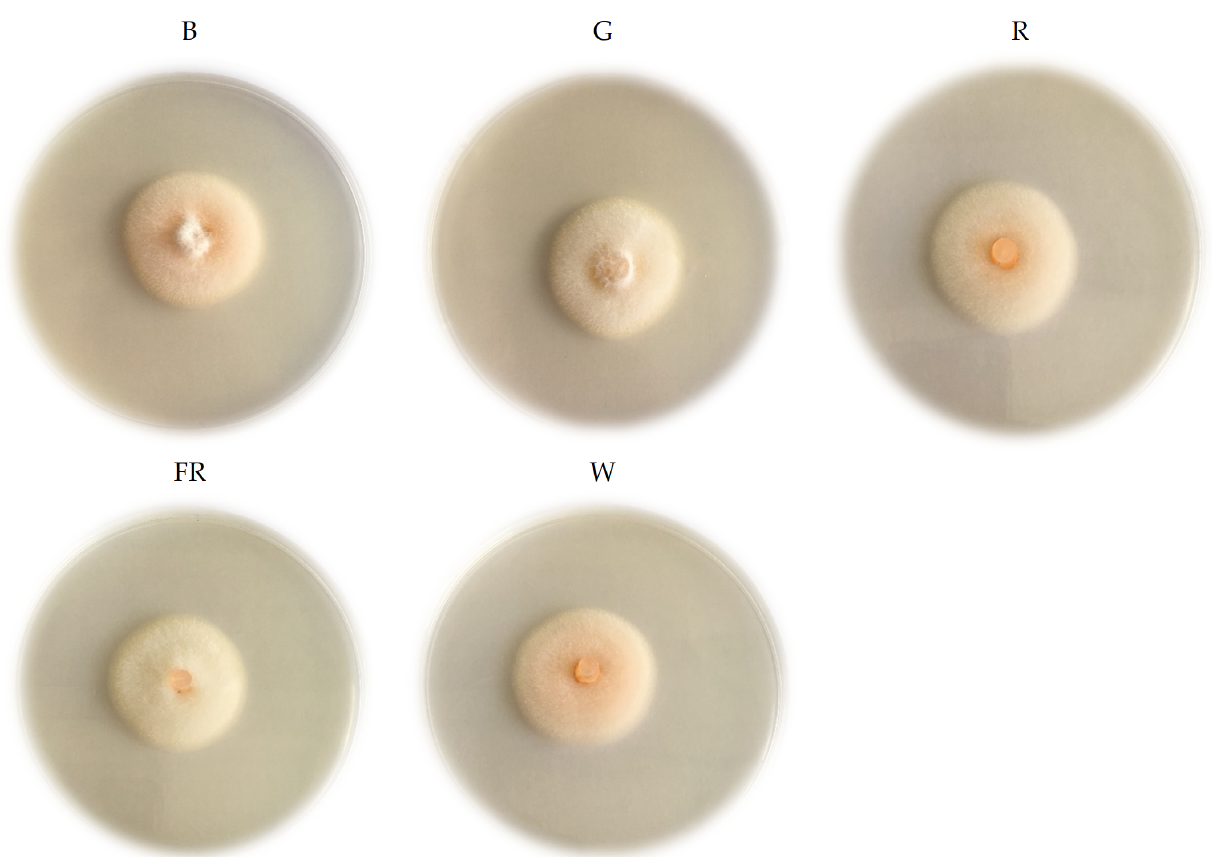
Figure 3. The mycelium appearance of C. acutatum under various LED light wavelengths. B—blue (peak = 450 nm); G—green (peak = 530 nm); R—red (peak = 660 nm); FR—far red (peak = 735 nm); W—white (5700 K).